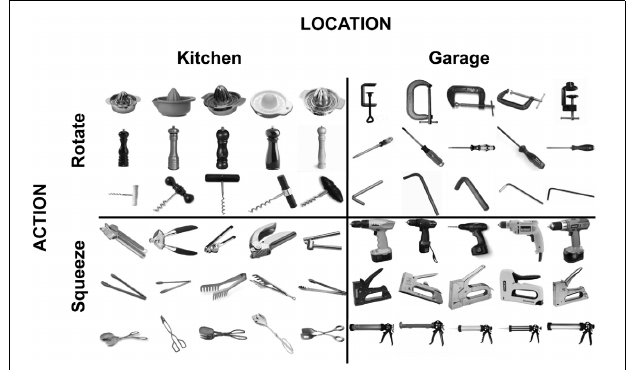
FIGURE 1 | Stimuli used in the fMRI and TMS